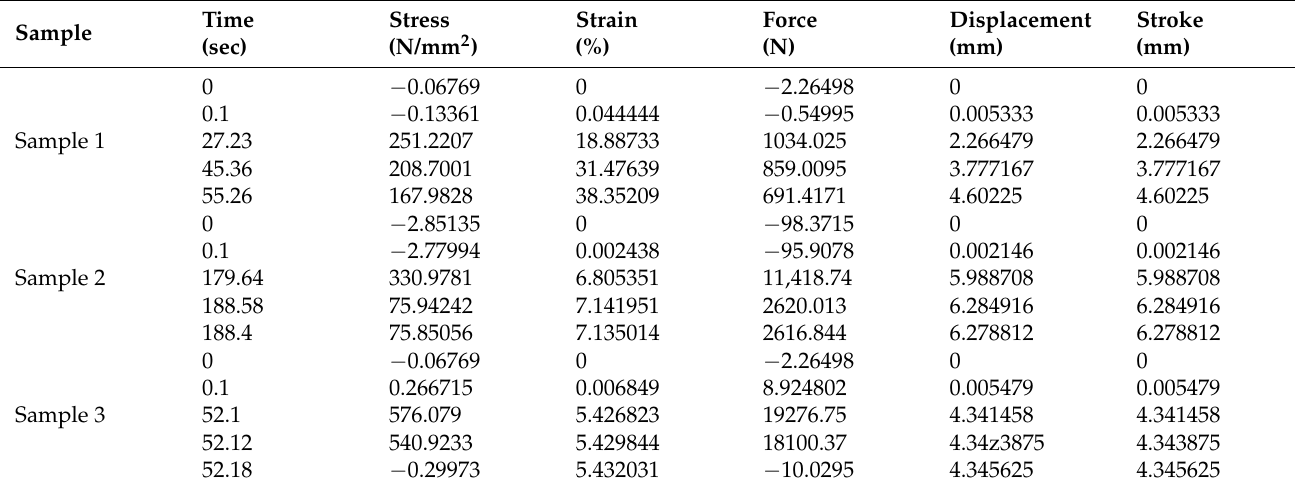
Table 3. UTM Generated Data for Carbon-fiber Composites.